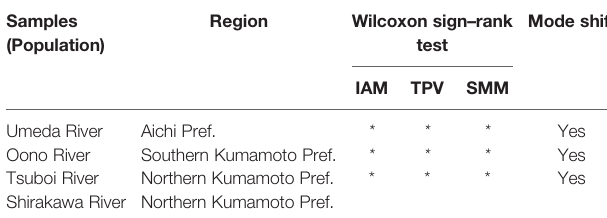
Southern Kumamoto Pref. * Yes Tsuboi River Northern Kumamoto Pref. * * * Yes Shirakawa River Northern Kumamoto Pref. “ yes ” indicates the existence of a mode shift in allele frequency. The sample in the Shirakawa River was excluded from the analysis because all the samples collected in the Shirakawa River were the same genet. *P <